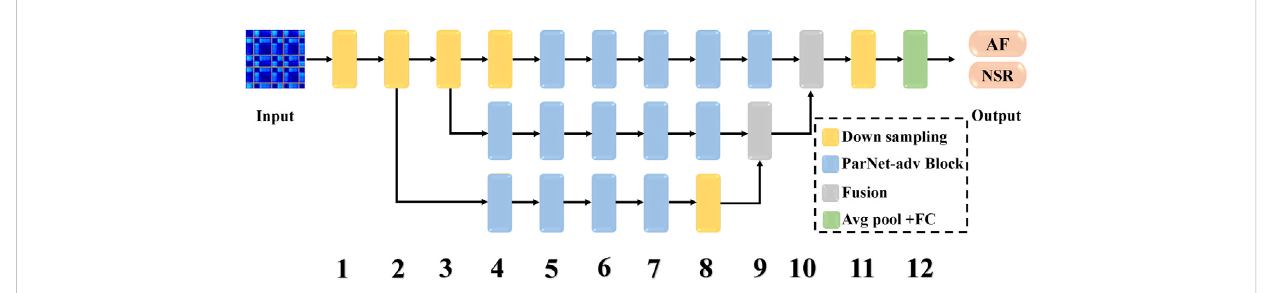
FIGURE 2 The architecture of the ParNet-adv for AF prediction. It consists of three parallel streams and four sub-networks, including ParNet-adv Block, Downsampling, Fusion, Avg pool + FC. The ParNet-adv model has only 12 depths of layers, the model inputs are RP images, and the outputs are the predictions of AF and NSR. AF, atrial fi brillation; NSR, normal sinus rhythm.